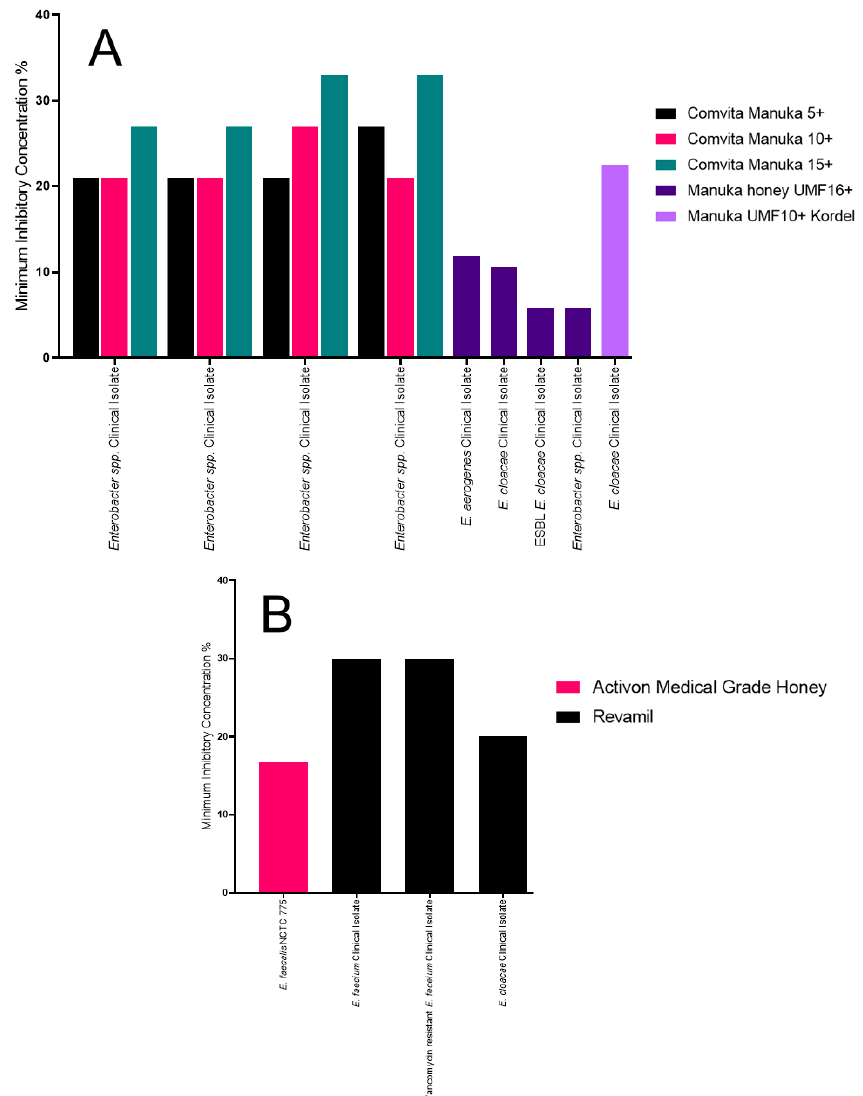
Figure 6. MICs of all other enteric bacterial isolates tested against a variety of Manuka and medical-grade honey. ( A ) All the Manuka honey MIC data used in this review, identifying the Manuka honey UMF16+ as the most effective; and ( B ) the medical-grade honey MIC data used in this review, identifying a similar activity between the Revamil and Activon medical-grade honeys.